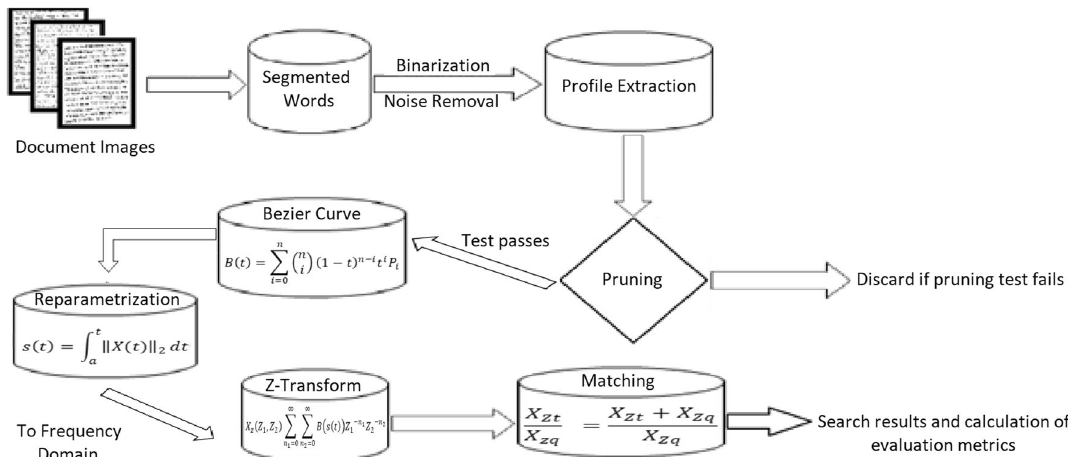
Fig. 1 Schematic diagram of the proposed keyword spotting method